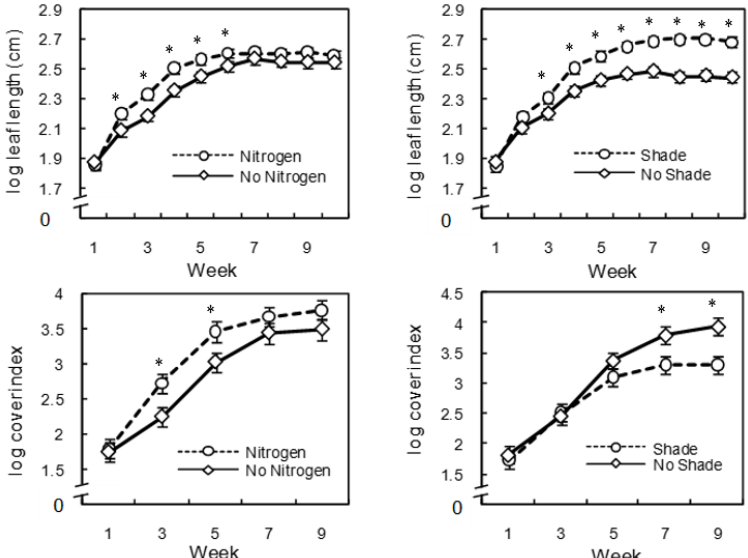
Figure 2. The effects of shade and nitrogen treatments on Idaho fescue leaf length and foliar cover. Dots represent the nitrogen or shade treatment group least squares means at each time interval while error bars are ± 1 standard error. Length was measured weekly throughout the experiment while cover was measured bi-weekly. Although not continuous data, lines between data points display the interaction between treatments and time. Significant differences ( p < 0.05) within time periods are identified by *.